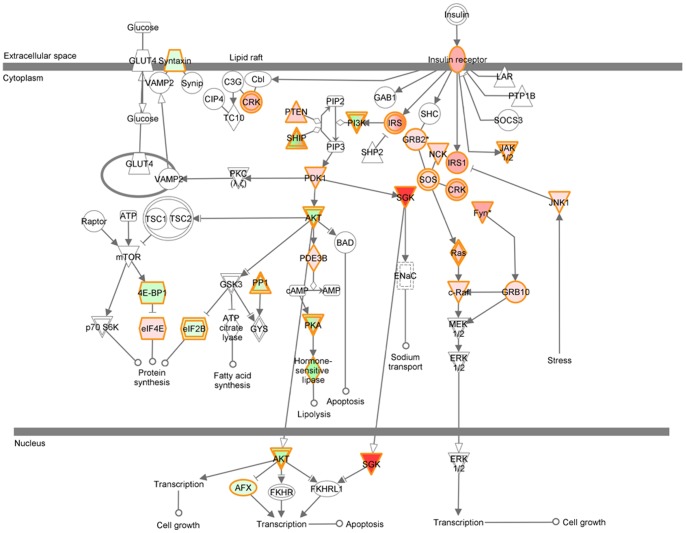
Diagram of the insulin signaling pathway modified by coding the change of transcripts in the BAT of rats responding to 4-hours of cold stimulation (4°C) as compared to the control group (22°C).Up-regulated transcripts are red (the darker red, the more up-regulation). Down-regulated ones are green (the darker green, the more down-regulation). The unchanged transcripts have no color. The signs between two components represent activation (arrow) and inhibition (bar or bar crossing arrow). Our data show that 4-hours of cold stimulation regulated multiple transcripts of the insulin signaling pathway in BAT of rats.